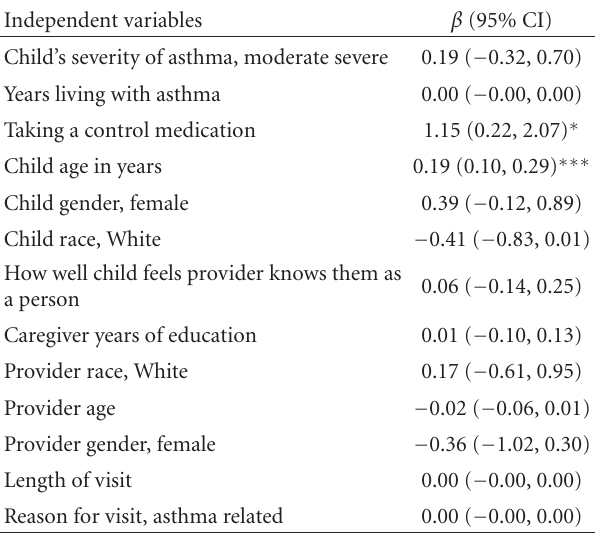
Table 4: Poisson generalized estimating equation results predicting the number of questions providers ask about control medications ( N =